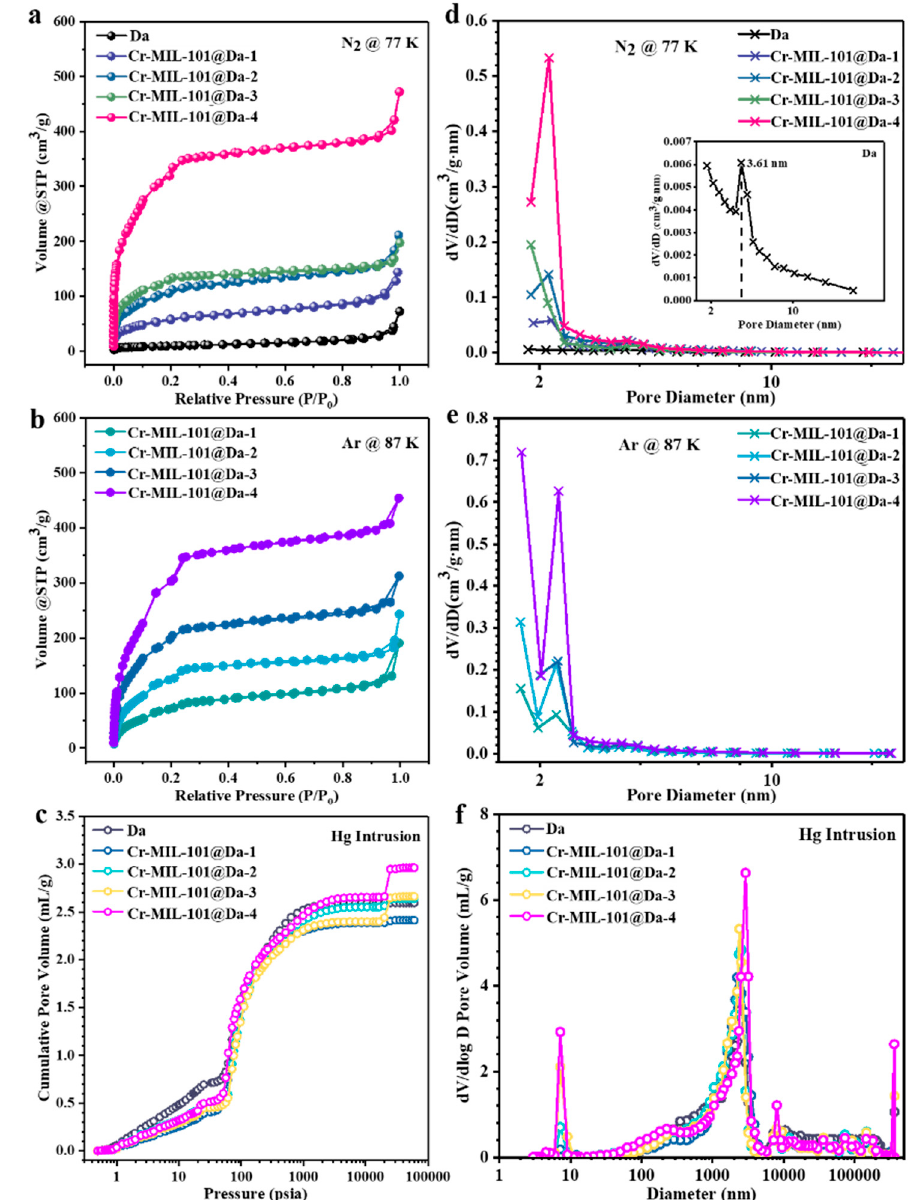
Figure 5. Porosity details for Da and Cr-MIL-101@Da. ( a ) N 2 adsorption–desorption isotherms at 77 K, ( b ) Ar adsorption–desorption isotherms at 87 K, ( c ) cumulative intrusion curves measured by MIP, BJH desorption pore diameter distributions derived from ( d ) N 2 , and ( e ) Ar adsorption–desorption and ( f ) pore size distribution curves derived from MIP.